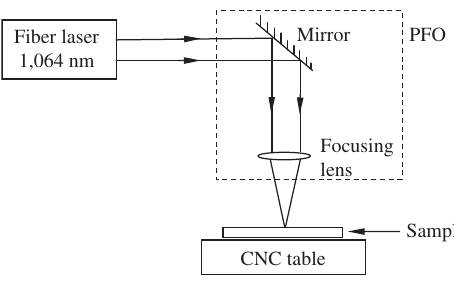
Figure 1: The schematic diagram of the laser scribing process.